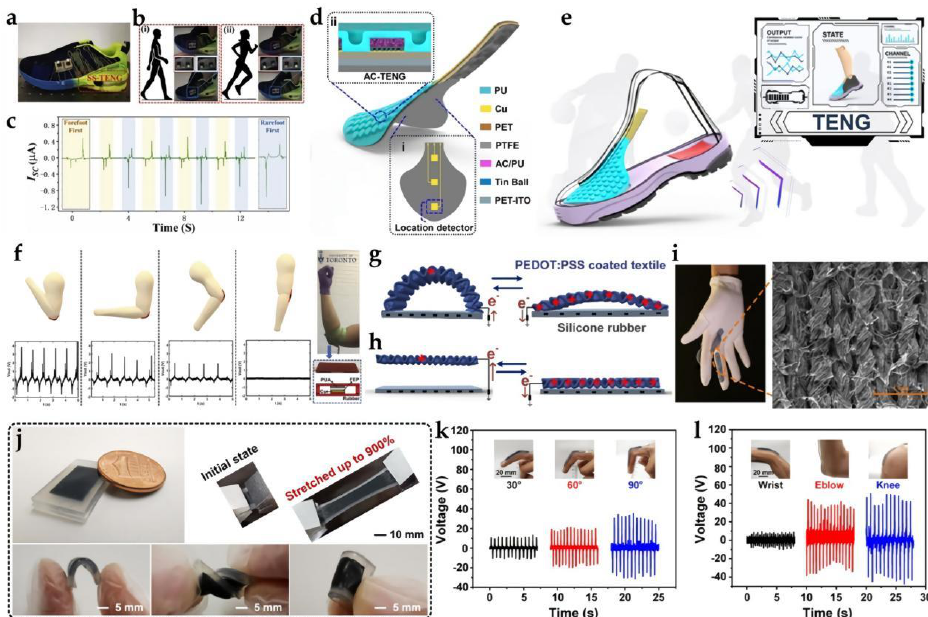
Figure 5. Applications of wearable TENG − based biosensors for motion. ( a ) Photograph of the SS − TENG installed into a common shoe; ( b ) Demonstration of a self-powered motion sensor by integrating LED circuit boards; ( c ) Current signals of SS − TENG under forefoot strike and rare foot strike. Reprinted/adapted with permission from Ref. [99]. 2019, Lin et al. Elsevier. ( d ) Two functional units constituting ISSP and their corresponding TENG of different modes: (i) layout diagram of location detectors on ISSP; (ii) internal structure diagram of an air-capsule TENG. ( e ) Dynamic detection applications based on IoT sensory system. Reprinted/adapted with permission from Ref. [97]. 2022, Yang et al. American Chemical of Society. ( f ) Effect of arm bending angle on the output signal of the PUA − TENG sensor. The right-hand-side inset shows the schematic and fabricated device. Reprinted/adapted with permission from Ref. [100]. 2019, Saadatnia et al. Elsevier. ( g ) Working mechanism of the arch-shaped TENG under the stretching and releasing state. ( h ) Working mechanism of the contact–separation TENG sensor. ( i ) Photograph of the glove-based interface. The inset shows an SEM image of the PEDOT: PSS-coated textile. Reprinted/adapted with permission from Ref. [101]. 2019, He et al. Elsevier. ( j ) Mechanical characterization of the super-stretchable TENG. ( k ) Proposed SS − TENG employed to detect the bending angles of knuckle. ( l ) SS − TENG used to qualitatively distinguish the motions of different human joints, including the wrist, elbow, and knee, according to the differences in amplitude and waveform of the output voltage. Reprinted/adapted with permission from Ref. [102]. 2021, et al.